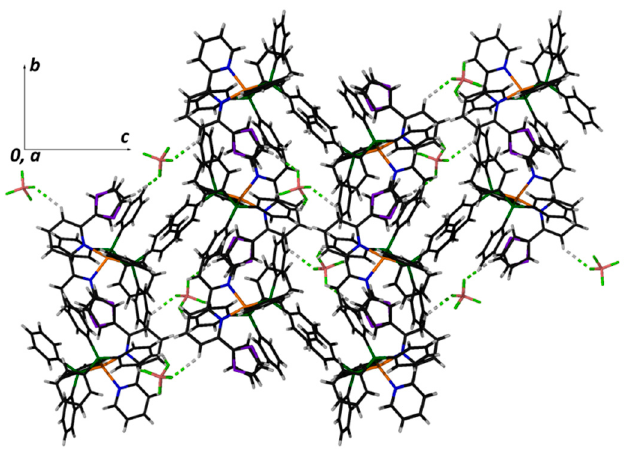
Figure 6. A packing diagram of 1 down to the a axis of the unit cell. Both positions of the disordered thiophenyl group and the non-conventional H-bonds are shown.